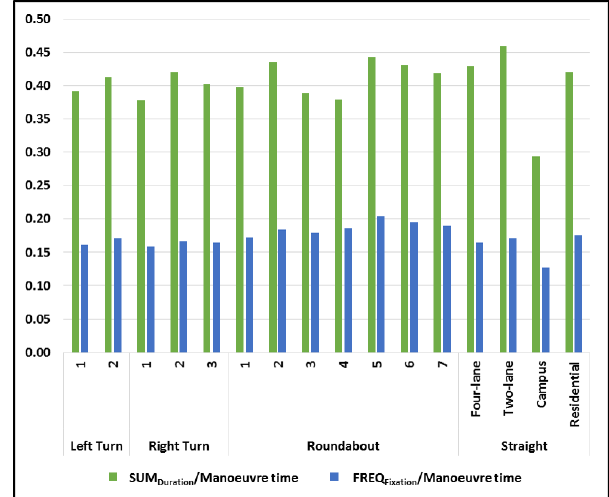
Figure 7. The statistics of SUM Duration /Manoeuvre time, and FREQ Fixation /Manoeuvre time at different driving manoeuvres and sections. Figure 8 compared the statistics of the maximum, mean and standard deviation of fixation durations for the 16 driv- ing sections. The maximum fixation durations (Max Duration ) of participants during straight road driving are significantly higher than both turns and roundabout performance. How- ever, the mean (Mean Duration ) and standard deviation of fix- ation durations (SD Duration ) are similar with the slightly lower values observed for roundabout